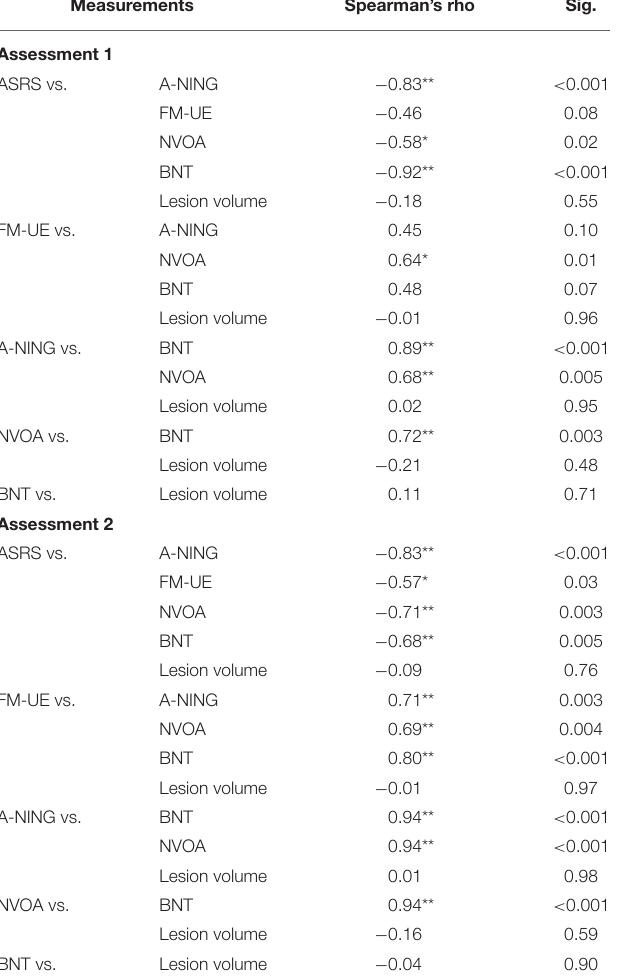
TABLE 5 | Descriptive statistics, recovery ratios. Sig.